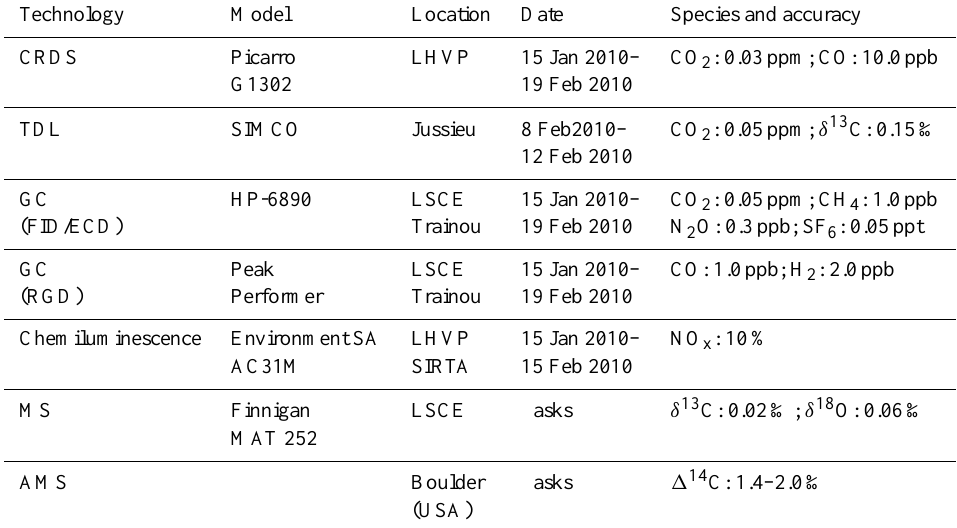
Table 1. Technologies, models, locations and accuracy of instruments for the analysed species with the respective measurement dates. Technology